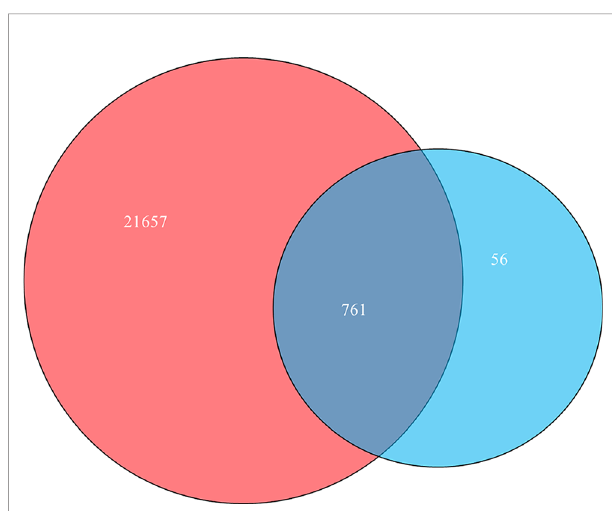
FIGURE 1 | Venn diagram of the potential anti-lung cancer